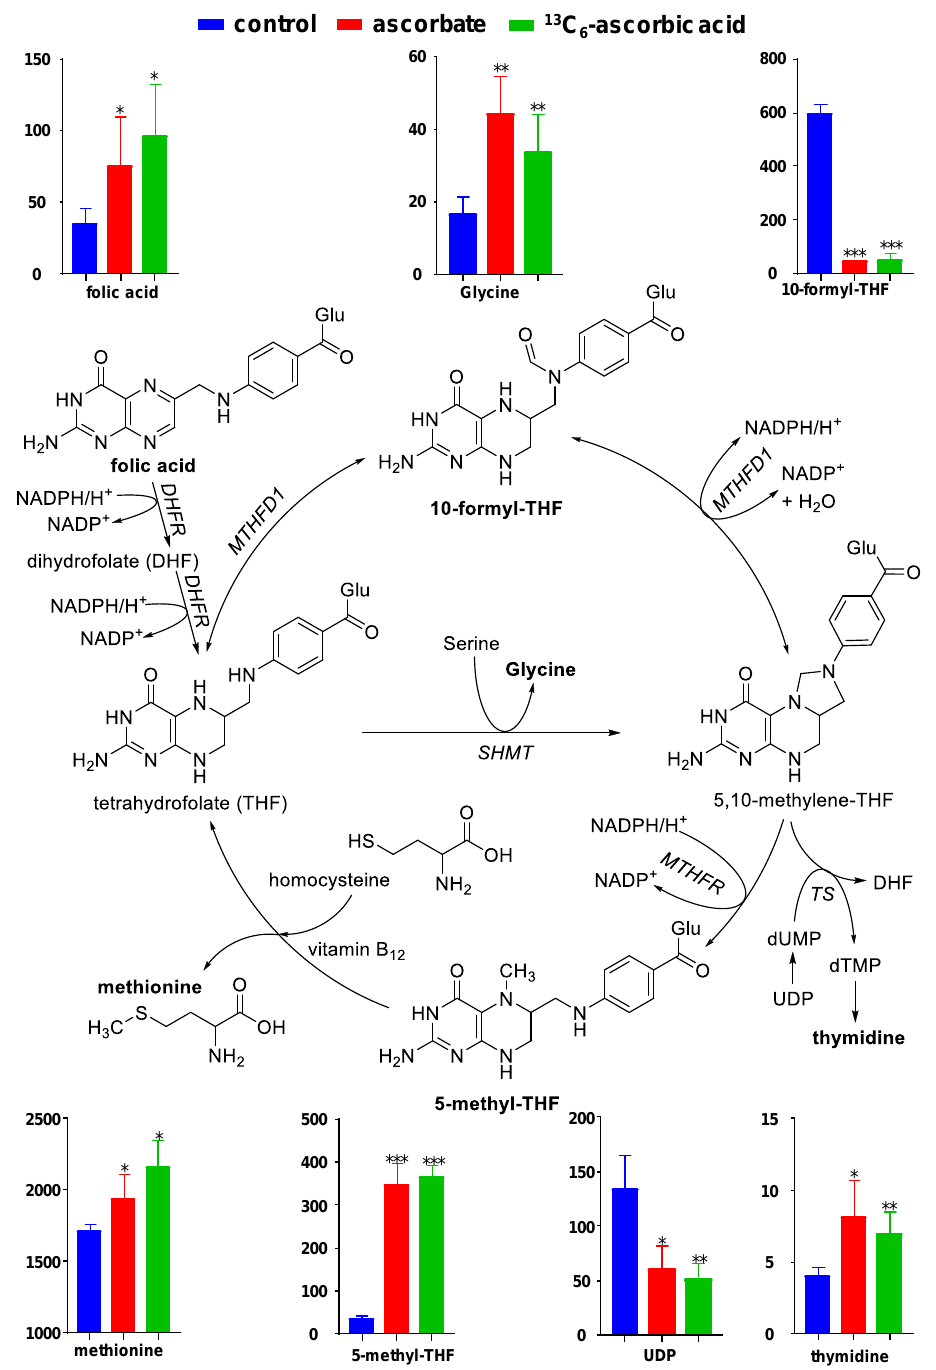
Figure 3. Simplified one-carbon cycle and associated pathways. Relative cellular levels of indicated metabolites are presented in the bar graphs (y-axes indicate peak areas expressed as 10 3 counts per second). Enzyme abbreviations: DHFR, dihydrofolate reductase; Glu, glutamic acid; MTHFD1, 5,10-methylene-THF dehydrogenase 1; MTHFR, 5,10-methylene-THF reductase; SHMT, serine hydroxymethyl transferase; TS, thymidylate synthase. Asterisks (*) indicate statistical significance between the control and treatment (*: p ≤ 0.05, **: p ≤ 0.01, ***: p ≤